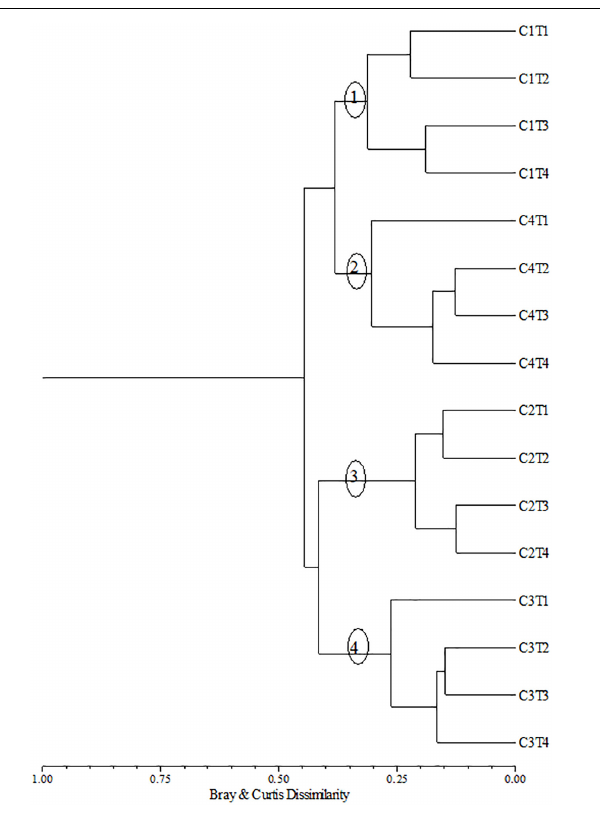
FIGURE 8 | Dendrogram of samples based on Copepoda density from the coastal and oceanic areas off Rio Grande do Norte, Southwestern Atlantic. Bray–Curtis index and Ward linkage clustering. C = Campaign (C1 = July 21–30, 2002, C2: May 12–30, 2003, C3: November 14–23, 2003, C4: May 17–31, 2004). T = Transect (T1: < 10 m, T2: 10–20 m, T3: 20–50 m, and T4: > 50